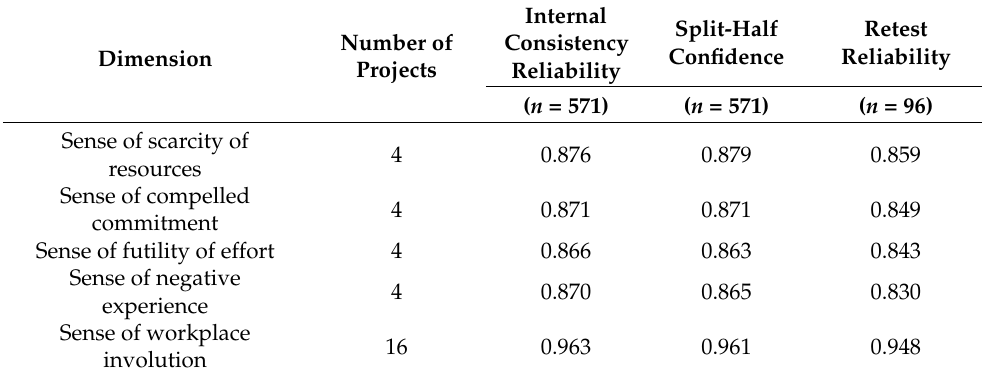
Table 4. Reliability analysis of the sense of workplace involution questionnaire.